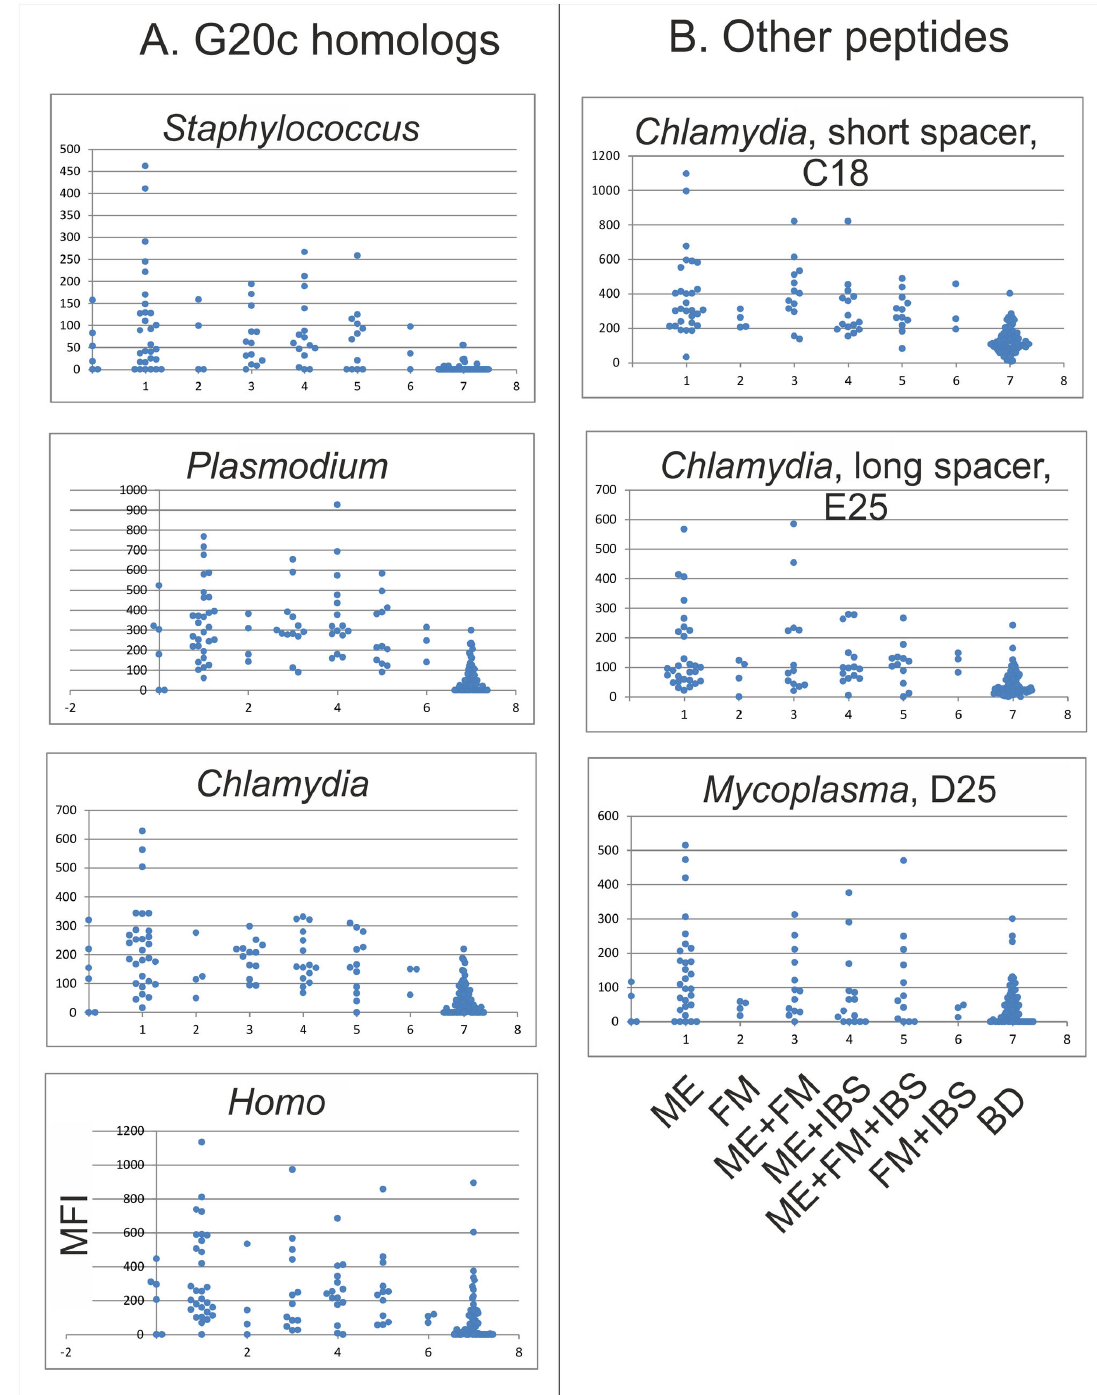
Figure 4. Needle plots of the most ME selective HSP60 peptides found in the Training set. All were from IgM assays. A. G20c homologs. The human HSP60 homolog is shown for comparison. B. Other HSP60 peptides. The Chlamydia E25 and Mycoplasma D25 peptides came from the carboxyl terminal half of HSP60, while the Chlamydia C18 came from its center, overlapping G20c and the apical helix I. ME patient samples are in lane 1, FM in lane 2, FM+ME in lane 3, ME+IBS in lane 4, ME +FM+IBS in lane 5, FM+IBS in lane 6 and BD in lane 7. The dots in lane 0 are from control samples (NTC, IgG, ME pool, etc). Ordinates: MFI. doi: 10.1371/journal.pone.0081155.g004 PLOS ONE |